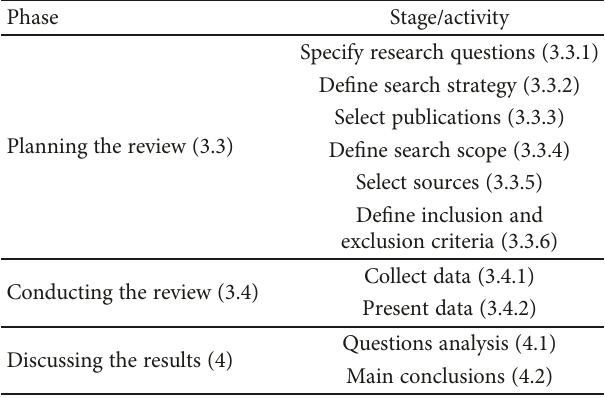
Table 1: Systematic review process applied in this study.